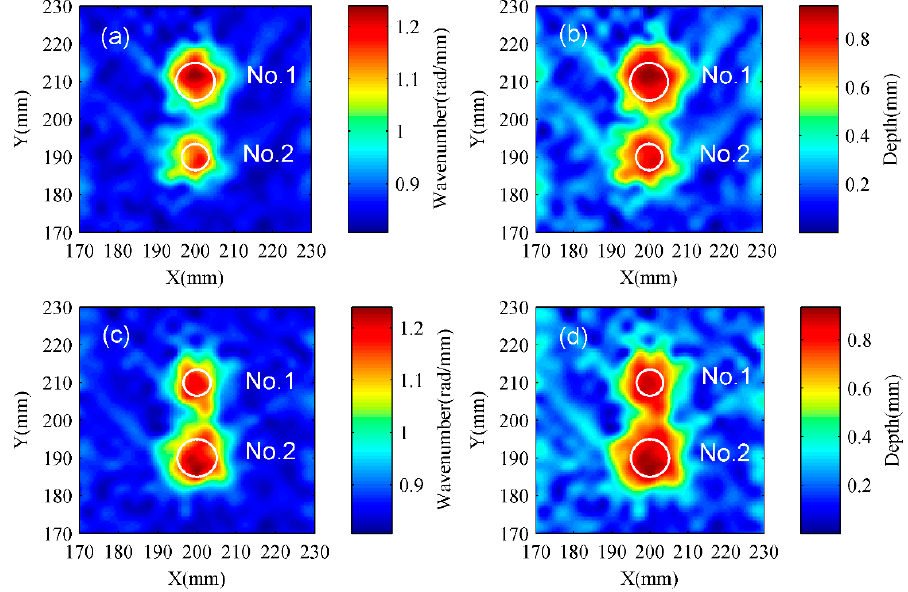
Figure 20. Experimental results of Case 8 and Case 9. ( a ) Wavenumber distribution of Case 8; ( b ) depth distribution of Case 8; ( c ) wavenumber distribution of Case 9; ( d ) depth distribution of Case 9. The white circle represents the actual location of the damage. The actual depth of the defect is 1 mm.